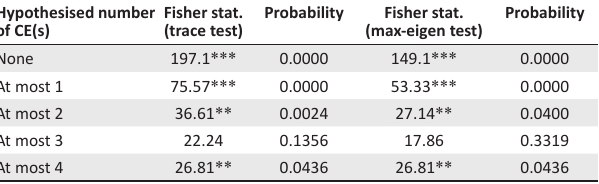
TABLE 3-A1: Johansen Fisher panel cointegration with linear deterministic trend test.